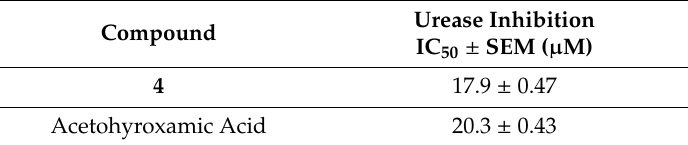
Table 3. Result of in vitro urease enzyme inhibition